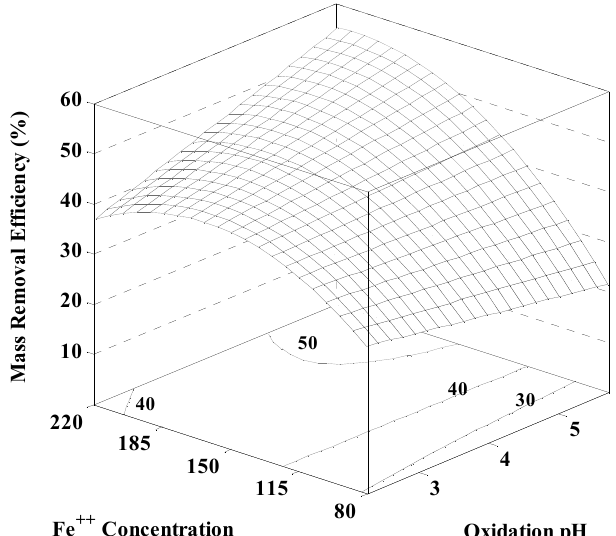
Fig. 4: MRE ( Y ). The response surface in terms of pH and Fe 2+ dosage ([H Fig. 4: MRE ( Y 3 ). The response surface in terms of pH and Fe 2+ dosage ( [H 2 O 2 ]/[Fe 2+ ] = 12 ) 3